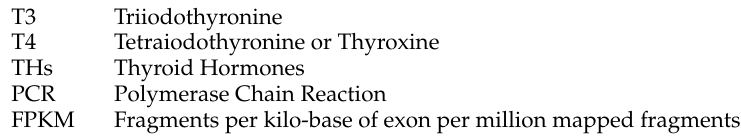
Table S1: Categorization of reads annotation, Table S2: Known mRNAs identified in porcine thyroid, Table S3: Table S5: Candidate lncRNAs with sequence similarities with human or mouse, Table S6: Novel mRNA identified in porcine thyroid, Table S7: Differentially-expressed mRNAs, Table S8: Differentially-expressed lncRNAs, Table S9: Genes involved in microtubule-based process, Table S10: LncRNA-mRNA pairs, Table S11: Primers for